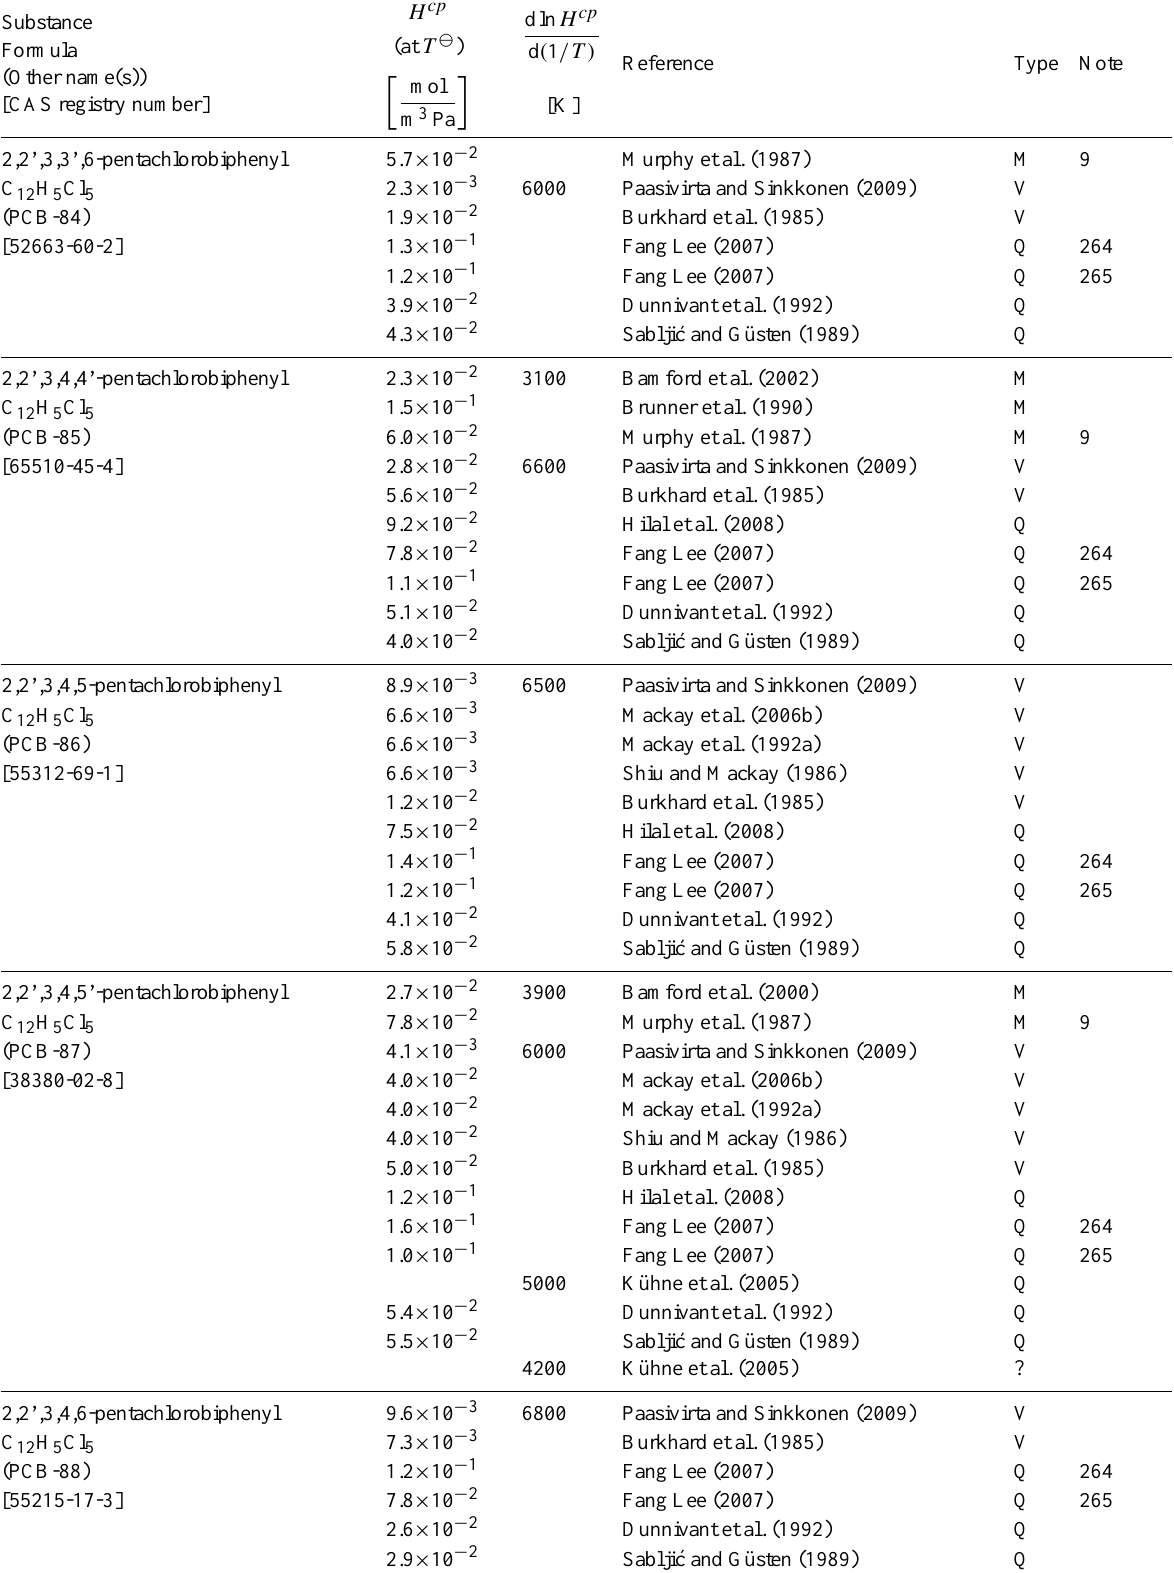
Table 6: Henry’s law constants for water as solvent